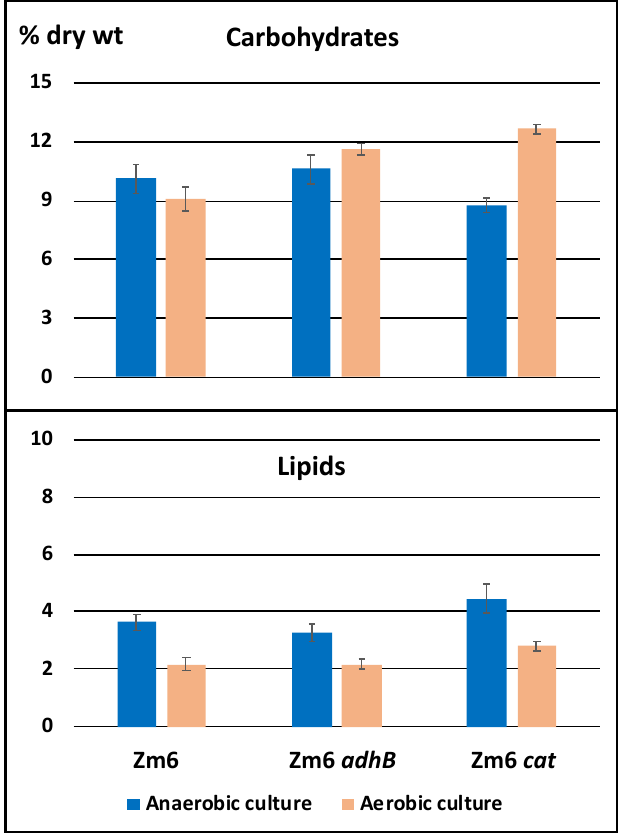
Figure 3. Total carbohydrate and lipid content (% of dry weight) in the stationary phase cells of Zm6, Zm6 adhB and Zm6 cat strains, grown under anaerobic or aerobic conditions.